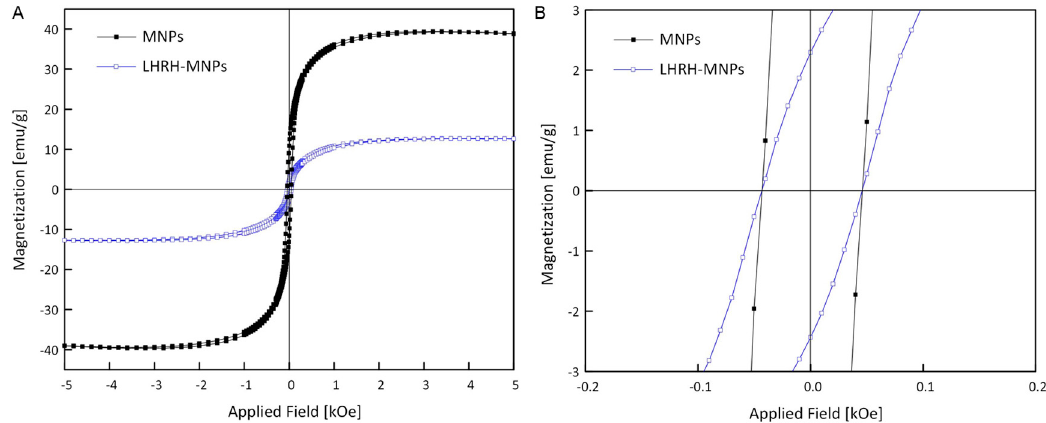
Figure 2. Magnetic hysteresis curves of MNPs and LHRH-MNPs with ( A ) full view with applied field ranging from − 5 kOe to 5 kOe. ( B ) Zoom of the hysteresis curves with applied field of ± 0.2 kOe, showing the coercivity of nanoparticles.